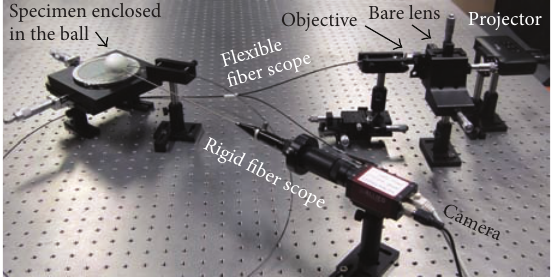
Figure 4: Experimental setup of the closed-space